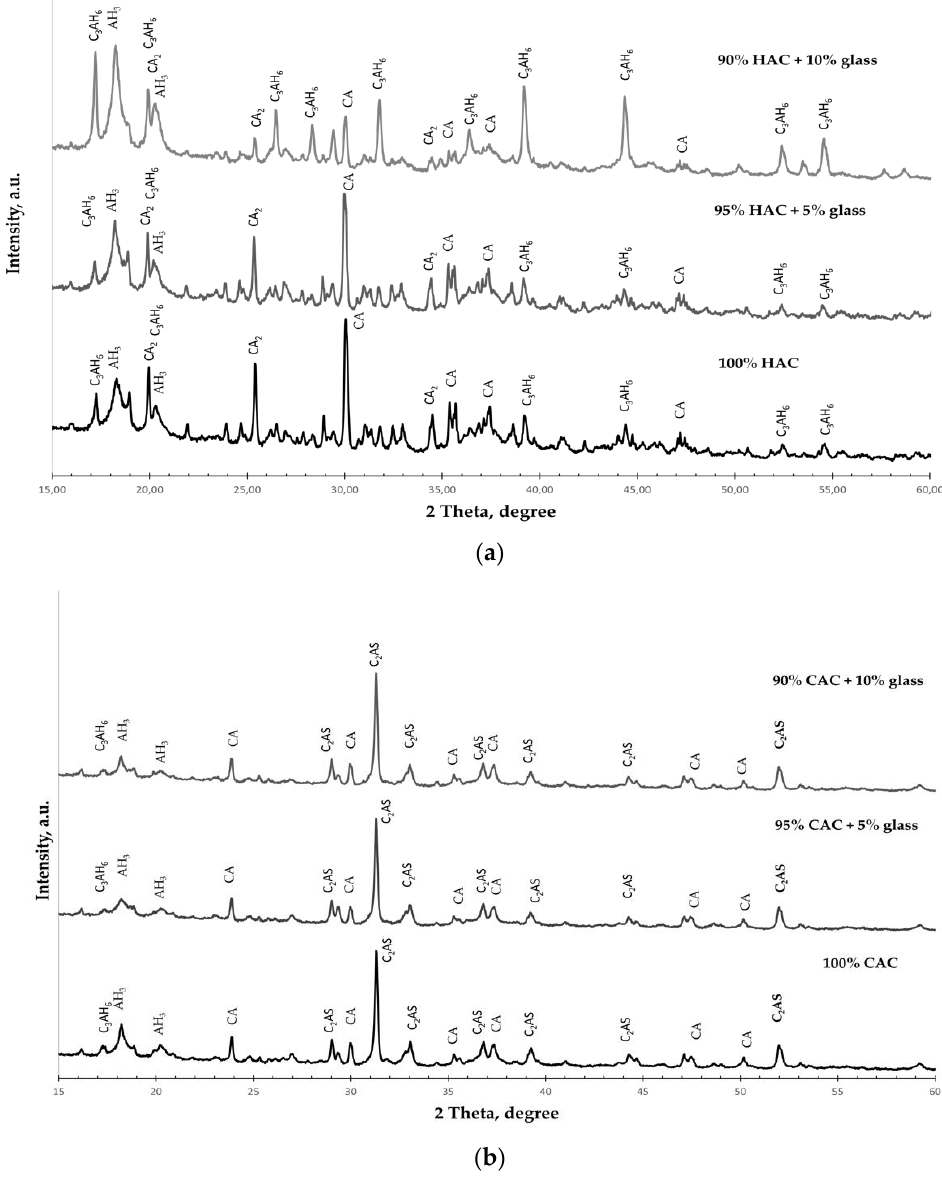
Figure 5. The XRD spectra for the pastes hydrated for 365 days. ( a ) HAC-glass systems; ( b ) CAC-glass systems.